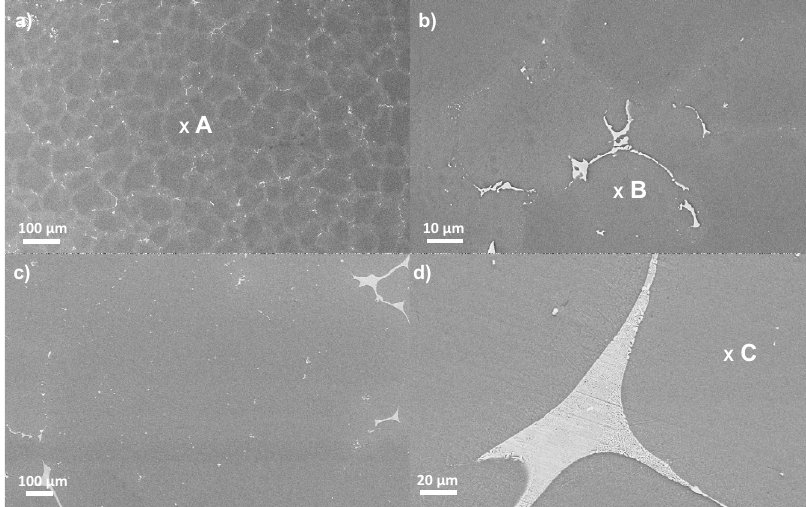
Fig. 1 Surface morphology of Mg-Zn-Zr alloys from casting. SEM images of a , b Mg – Zn – Zr(AC) and c , d Mg – Zn – Zr(Sol).